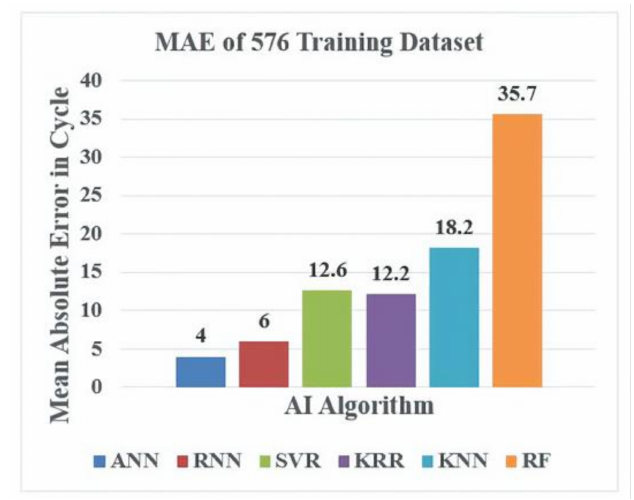
Figure 15. MAE analysis vs. AI model for 576 training datasets.